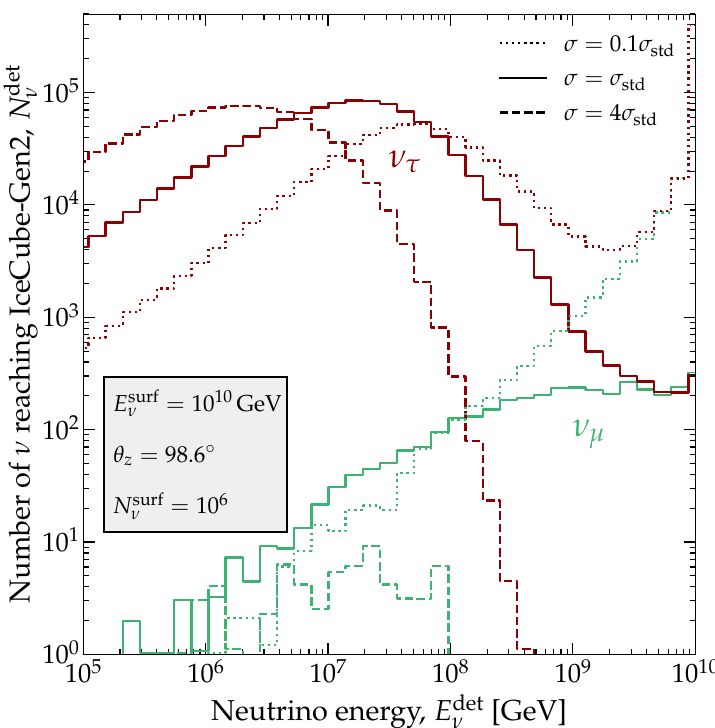
Figure 8 . Sample histograms of the number of UHE ν µ and ν τ that reach the detector after propagating through the Earth. At the surface of the Earth, opposite to the detector, we inject a mono-energetic beam of N surf = 10 6 neutrinos, each with energy E surf = 10 10 GeV, pointed toward ν ν the detector along a zenith angle θ = 98 . 6 ◦ . We show cases of neutrinos propagated using the z central value of the BGR18 νN DIS cross section ( σ ) [63], and sample scaled-up and scaled-down std versions of it. For our analysis, we pre-compute histograms for many more values of E surf , θ , z ν